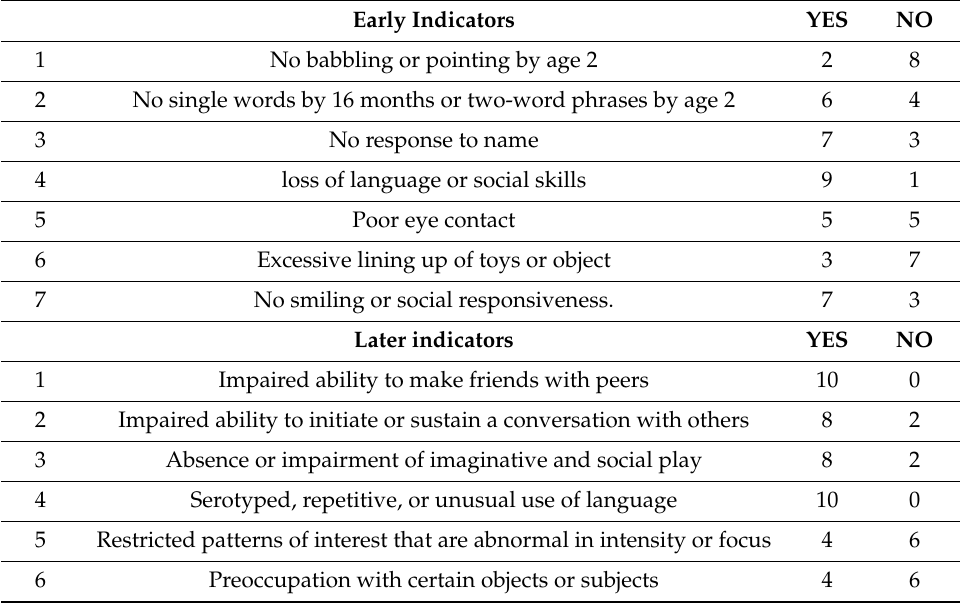
Table 1. Early and late signs of Autism in children included in this study. Early